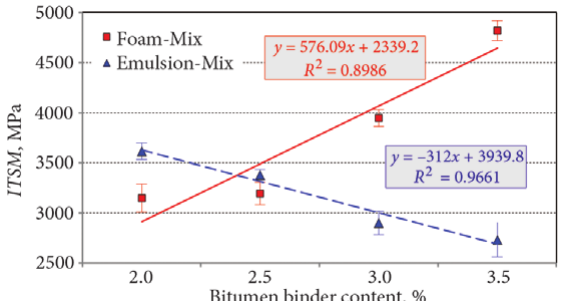
Fig. 6. The impact of the type and amount of bitumen binder on indirect tensile stiffness